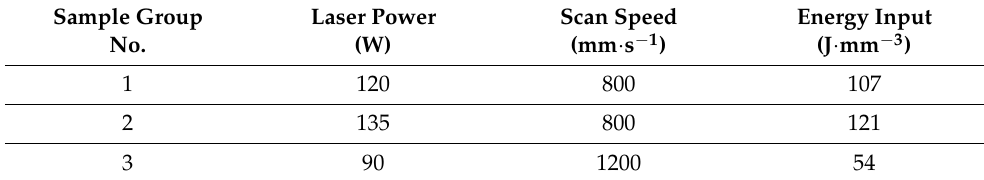
Table 1. Process parameters of L-PBF